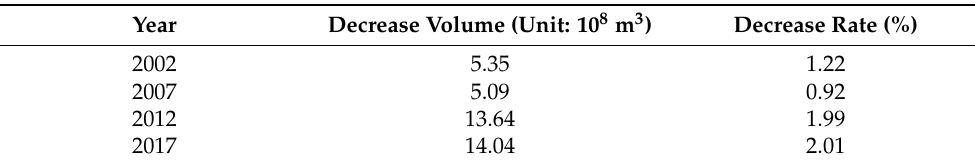
Table 2. Wastewater reduction effects to the entire economic system by reducing 10% final demand on sectors in WPCs.